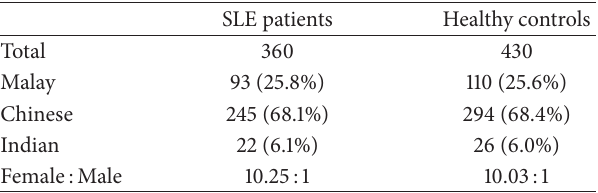
Table 1: Distribution of samples according to ethnicity and gender. The percentage of SLE patients and healthy controls was ethnic- and gender-matched.